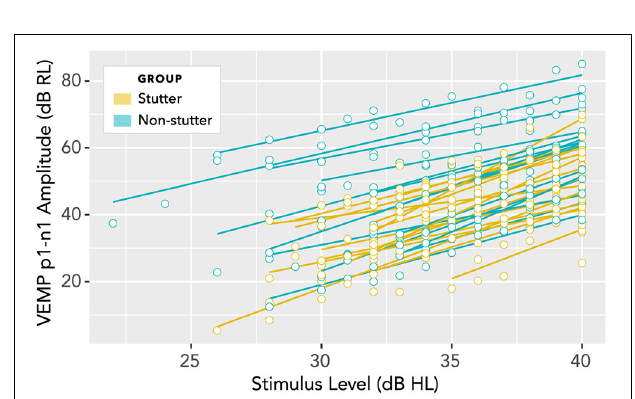
FIGURE 10 | Per participant slopes of stimulus level (dB HL) versus VEMP p1-n1 amplitude (dB RL). Log transformation on the ordinate is such that a 6 dB increase corresponds to a doubling of the VEMP p1-n1 amplitude in normalised microvolts (i.e., with unity RMS background). A fixed slope, varying intercept model is supported if the least squares fit lines shown in this diagram are considered approximately parallel. Analyses of varying slope linear mixed models for these data are available in the Supplementary Material